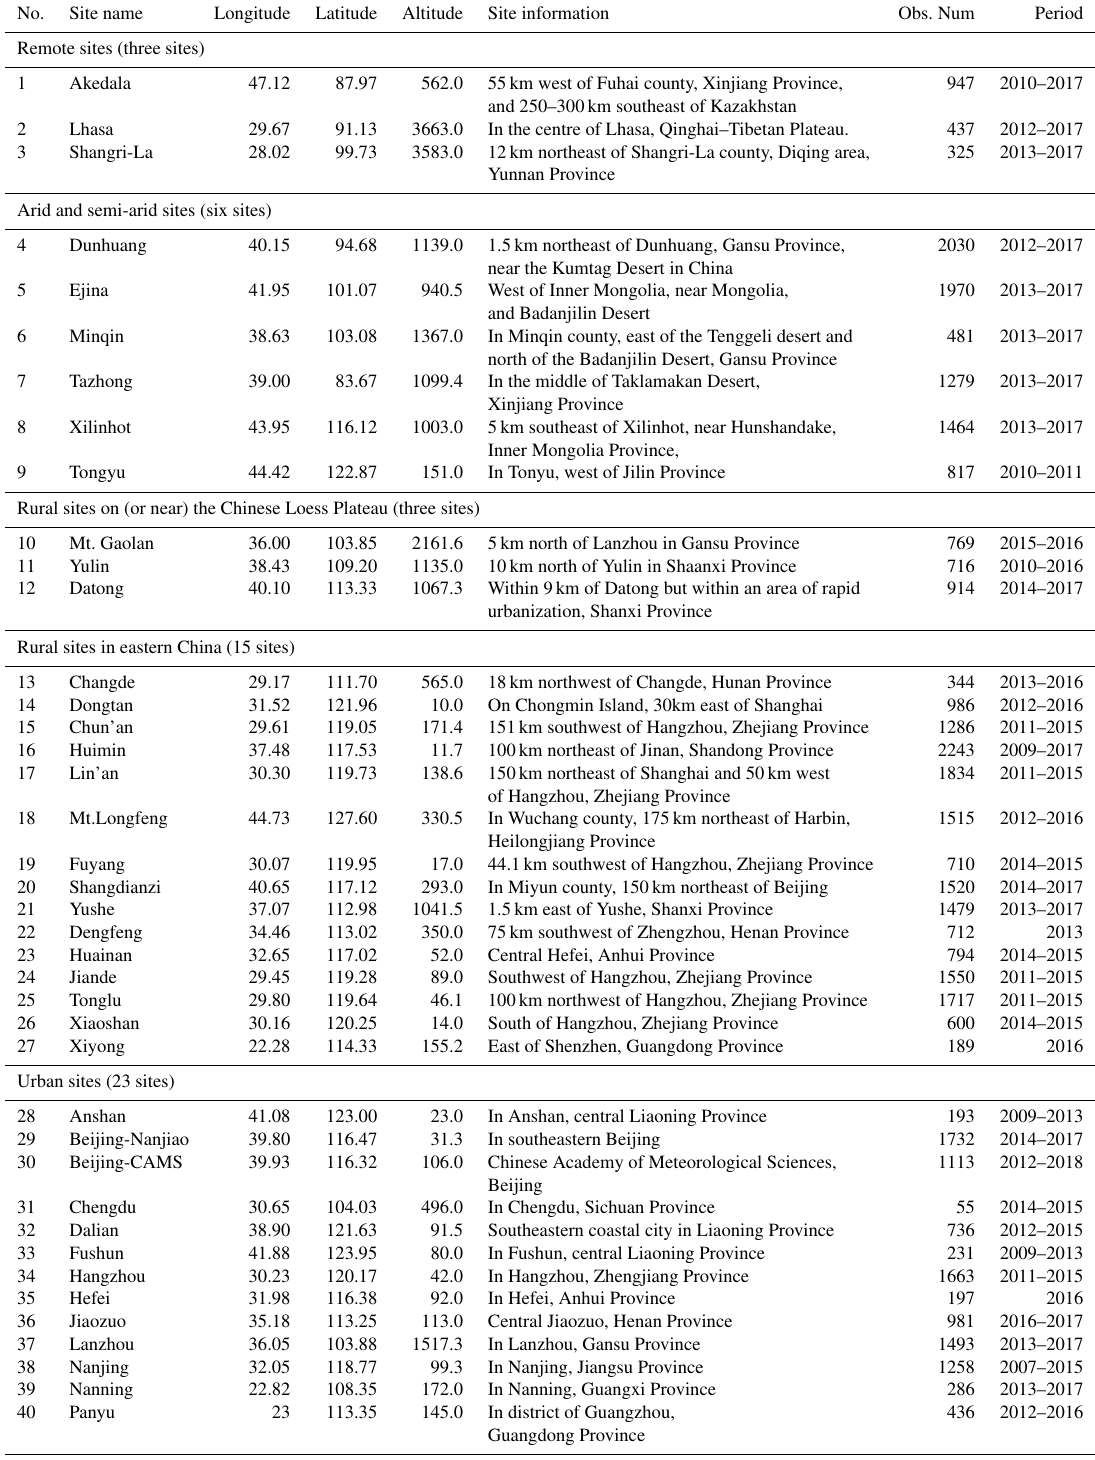
Table A1. Site information for the 50 CARSNET sites used in this